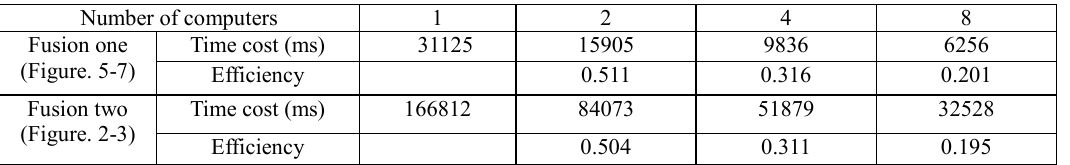
Figure 7.The fusion result image of Beijing-1 small satellite with the proposed method of image fusion in the